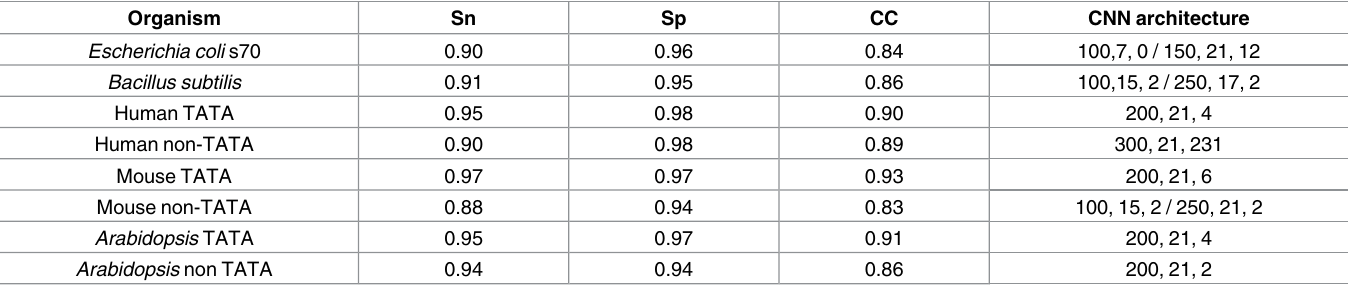
Table 2. The accuracyand parameters of CNN models. Architecture as 200, 21, 4 describesone layer with 200 filters, filter length 21 and poolingsize 4; ‘/’ separates data for two layers.